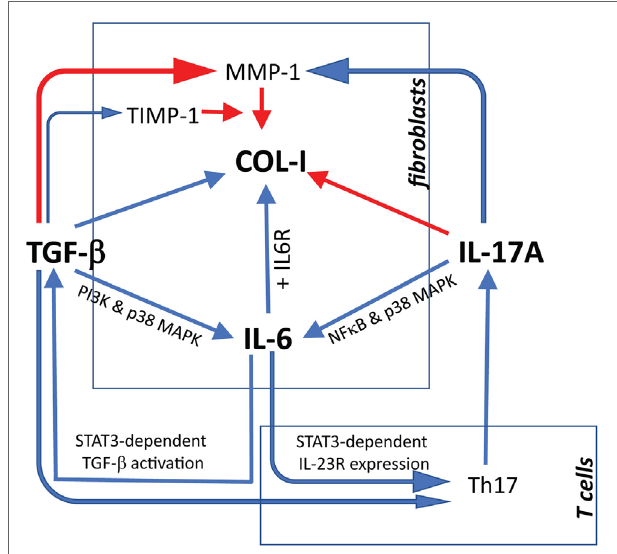
FigUre 9 | Proposed model linking IL-17A, TGF- β , and IL-6 in the context of extracellular matrix deposition and Th17 cell differentiation. Blue arrows: stimulatory signal; red arrows: inhibitory signal. The relevant references are reported in the discussion. For tissue inhibitor of metalloproteinases 1 (TIMP-1), we refer to Fineschi et al.